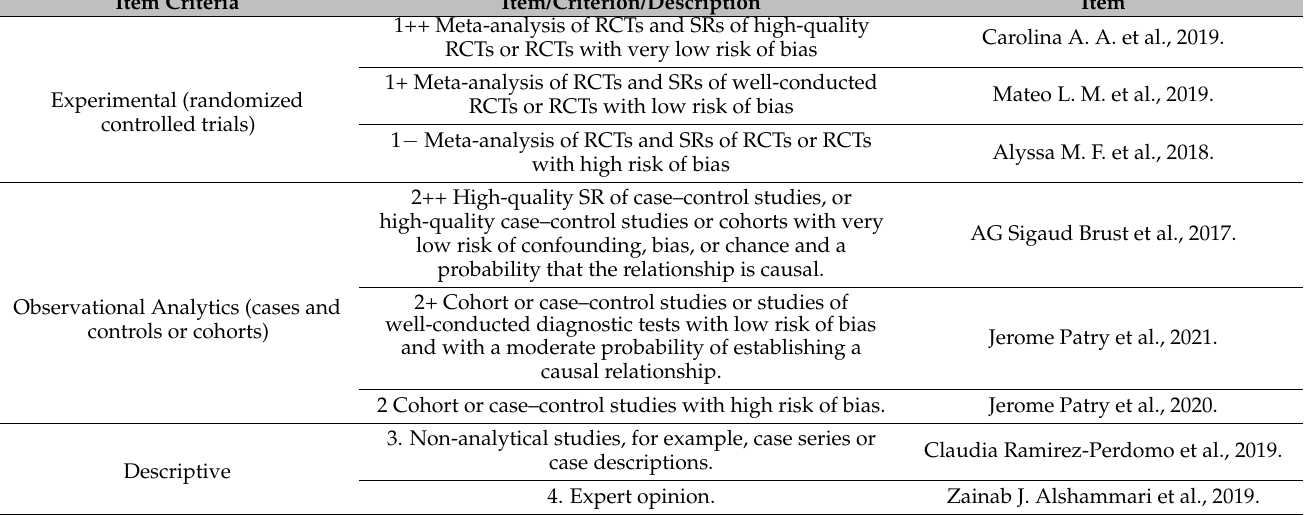
Table A2. Scottish Intercollegiate Guidelines Network